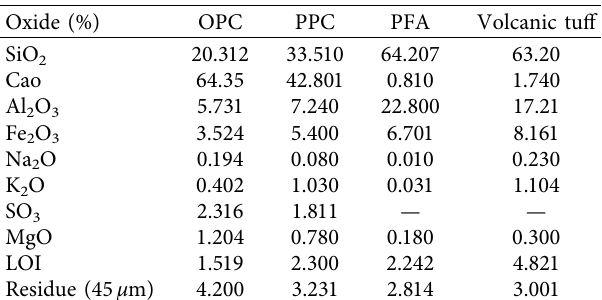
Table 1: Results of chemical analysis of the test materials